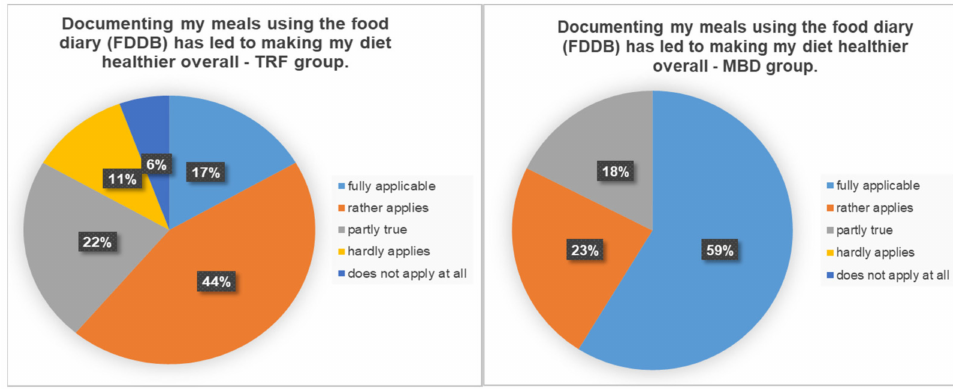
Figure 5. Percentage distribution on the question of whether documenting the meals using the food diary had a positive effect for a healthier diet.